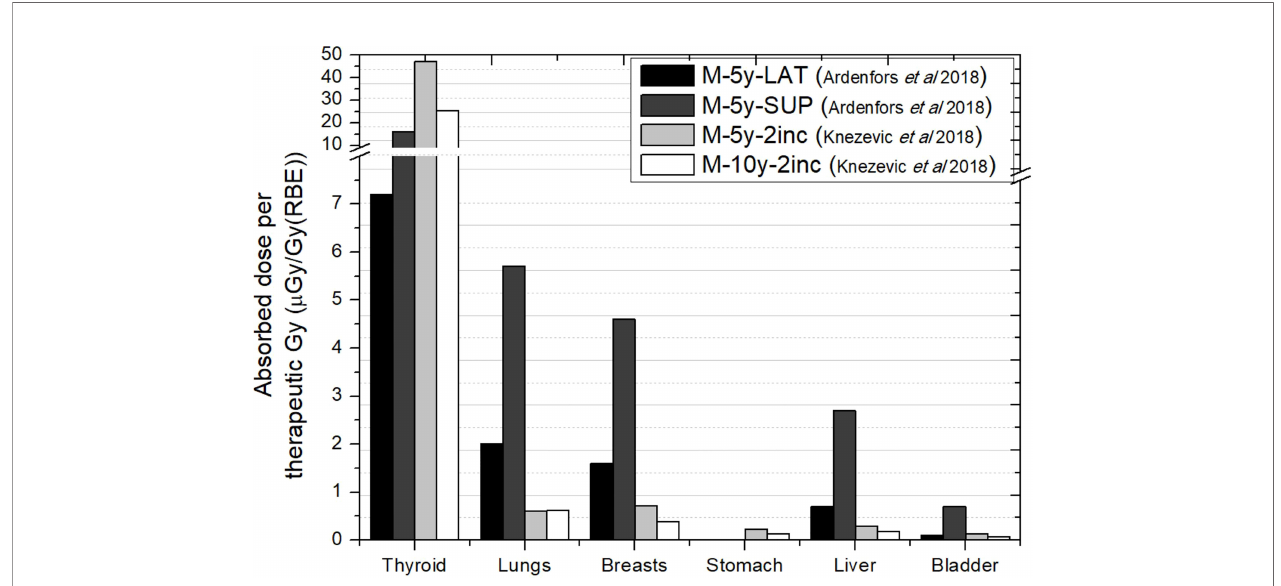
FIGURE 4 | Absorbed doses per therapeutic Gy in selected organs for a brain treatment in two different proton pencil beam scanning facilities. Data extracted from Ardenfors et al. (36) (total absorbed dose) and Knez ̌ evic ́ et al. (38) (photon absorbed dose). In the legend, the sex (F, female; M, male), age of the patient (#y=number of years) and number of incidences (#inc = number of incidences) are speci fi ed. LAT, Lateral fi eld; SUP, Anterior – superior fi